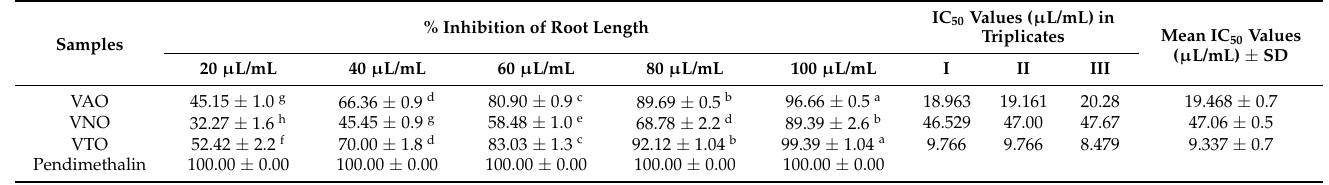
Table 3. Mean % inhibition and IC 50 values for root length inhibition by tested essential oils.